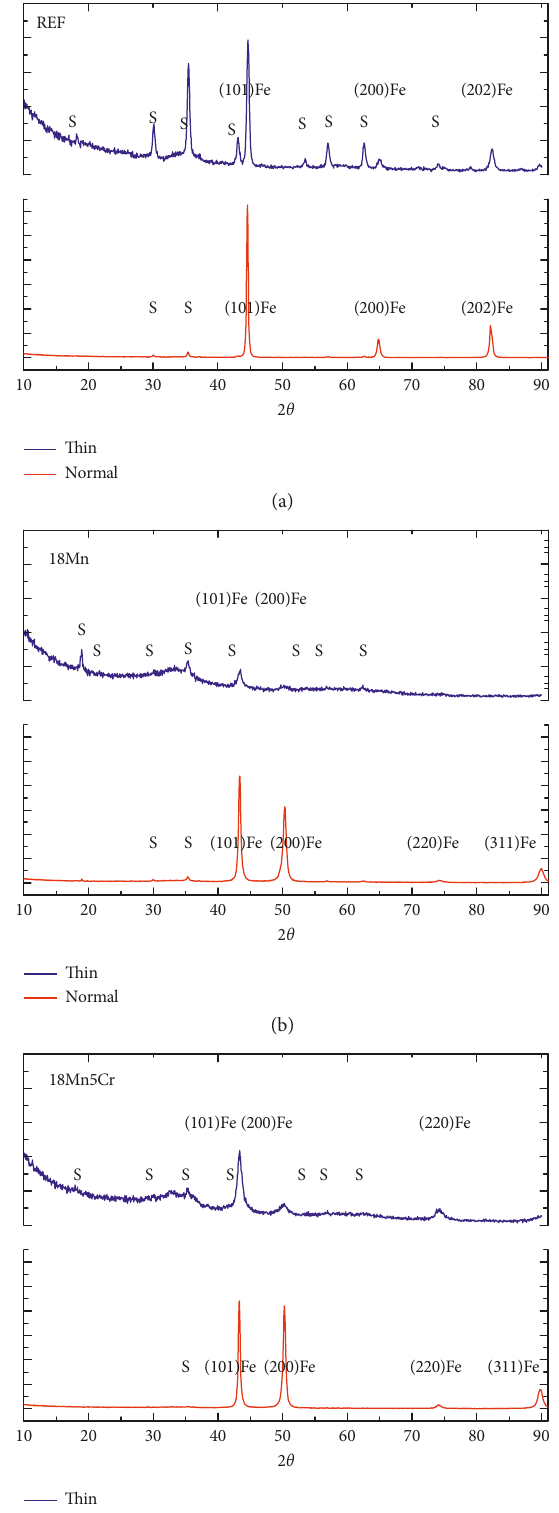
Figure 5: XRD patterns of the adherent rust (AR) formed on (a) REF, (b) 18Mn, and (c) 18Mn5Cr for 56 days in 3.5% NaCl solution at 60 ° C, where S represents magnetite (or